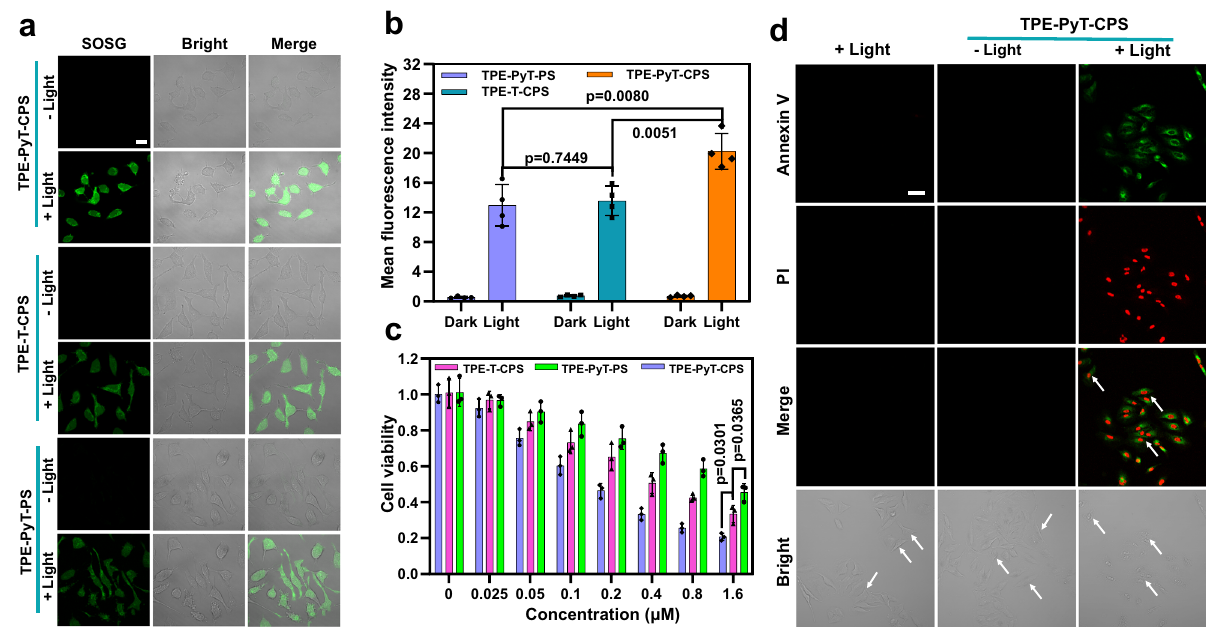
Fig. 5 Intracellular ROS, cytotoxicity and cells apoptosis induced by PDT. a Intracellular 1 O 2 detection by CLSM after HeLa cells were incubated with different AIEgens including TPE-PyT-CPS (0.2 μ M), TPE-T-CPS (0.4 μ M), TPE-PyT-PS (0.4 μ M) and SOSG under laser irradiations (25 mW cm − 2 , 2 min). Scale bar, 20 μ m. b Average fl uorescence intensity of SOSG after the HeLa cells incubated with different AIEgens and under laser irradiations for 2 min (25 mW cm − 2 , n = 4 biologically independent experiments). c Cell viabilities of HeLa cells after incubation with varied concentrations of TPE-T-CPS, TPE- PyT-PS and TPE-PyT-CPS with 532 nm laser irradiation for 2 min (65 mW cm − 2 , n = 3 biologically independent experiments). d Apoptosis of HeLa cells treated with TPE-PyT-CPS (0.2 μ M) under 532 nm laser (65 mW cm − 2 , 2 min). Scale bar, 50 μ m. Experiments in 5a and 5d were performed three times independently, representative images are shown. Data in 5b and 5c are presented as mean ± SD. Statistically signi fi cant differences between the experimental groups were analyzed by two-tailed Student ’ s t- test. when p < 0.05, it was considered to have statistical signi fi cance. Source data are provided as a Source Data fi